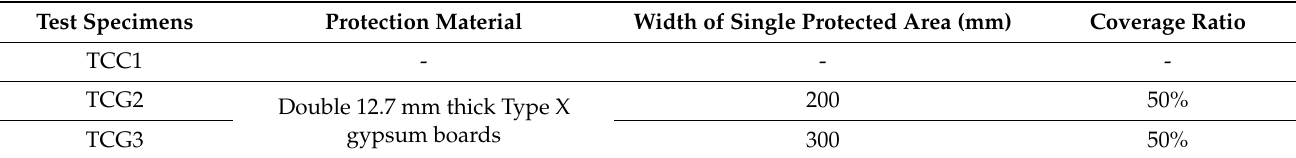
Table 1. Main parameters of composite board specimens.